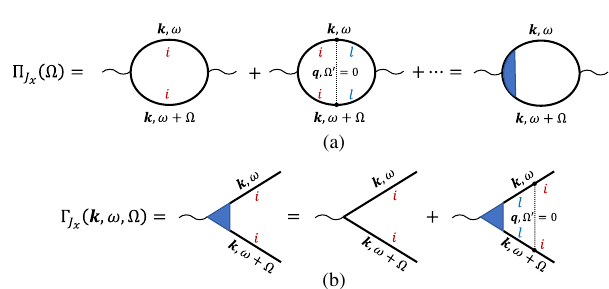
Ω Þ in the q ¼ 2 xx ð